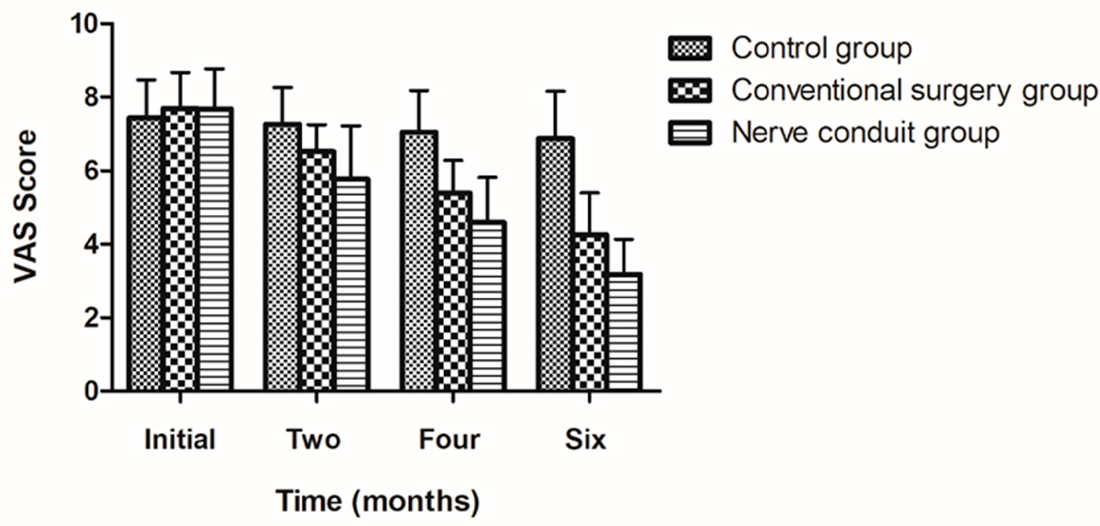
Figure 3. The figure illustrate the results of the VAS levels at different time points for each group Figure 3. The fi gure illustrate the results of the VAS levels at di ff erent time points for each group (mean ± (mean ± SD).